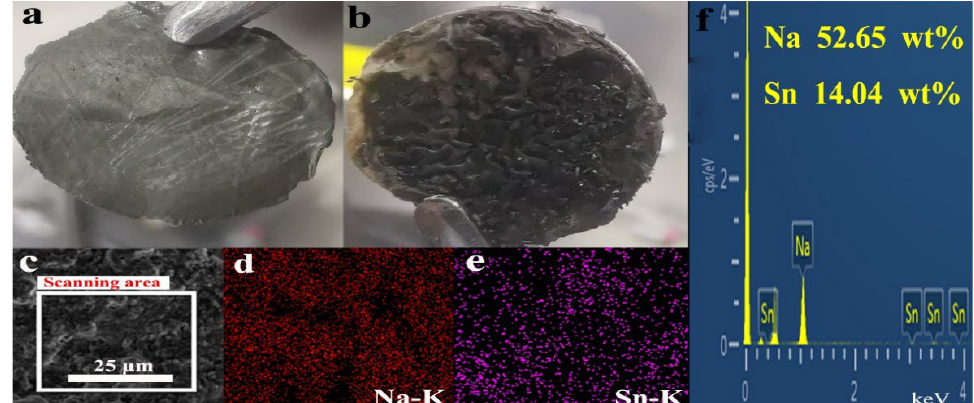
Figure 6. Low magnification FESEM images of sodium-tin alloy derived by ( a ) pure Sn foil and ( b ) Sn foil inlaid with Na metal ring; ( c )The representative district scanning and corresponding element mappings: ( d ) Na and ( e ) Sn; ( f ) the electron diffraction spectra (EDS) of sodium-tin alloy.